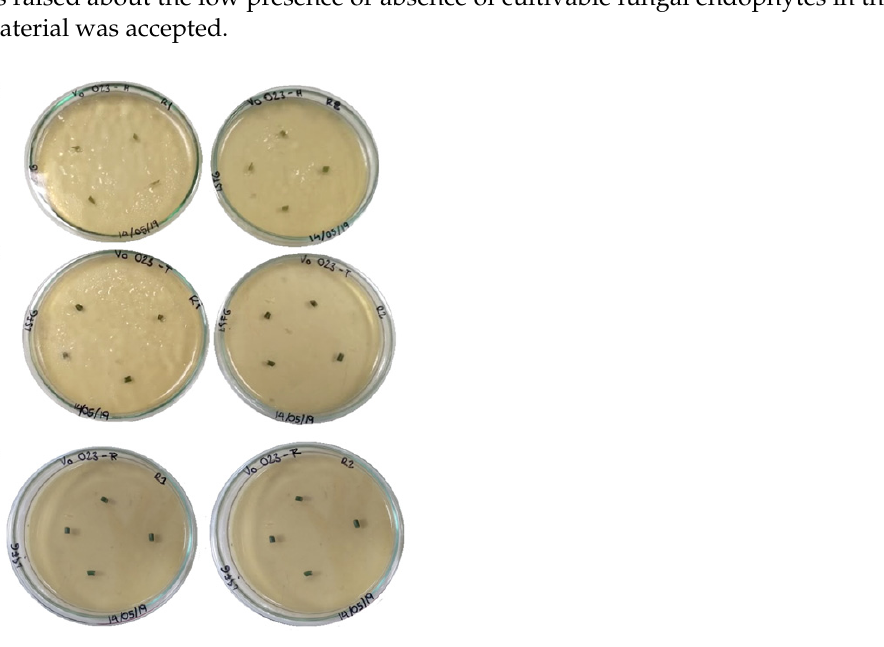
Figure 1. Tissue seeding of vanilla accessions multiplied in vitro 10 days later, for isolation of endophytic fungi on PDAa: ( A ) leaf cuts; ( B ) stem sections; ( C ) main terrestrial root cuttings.